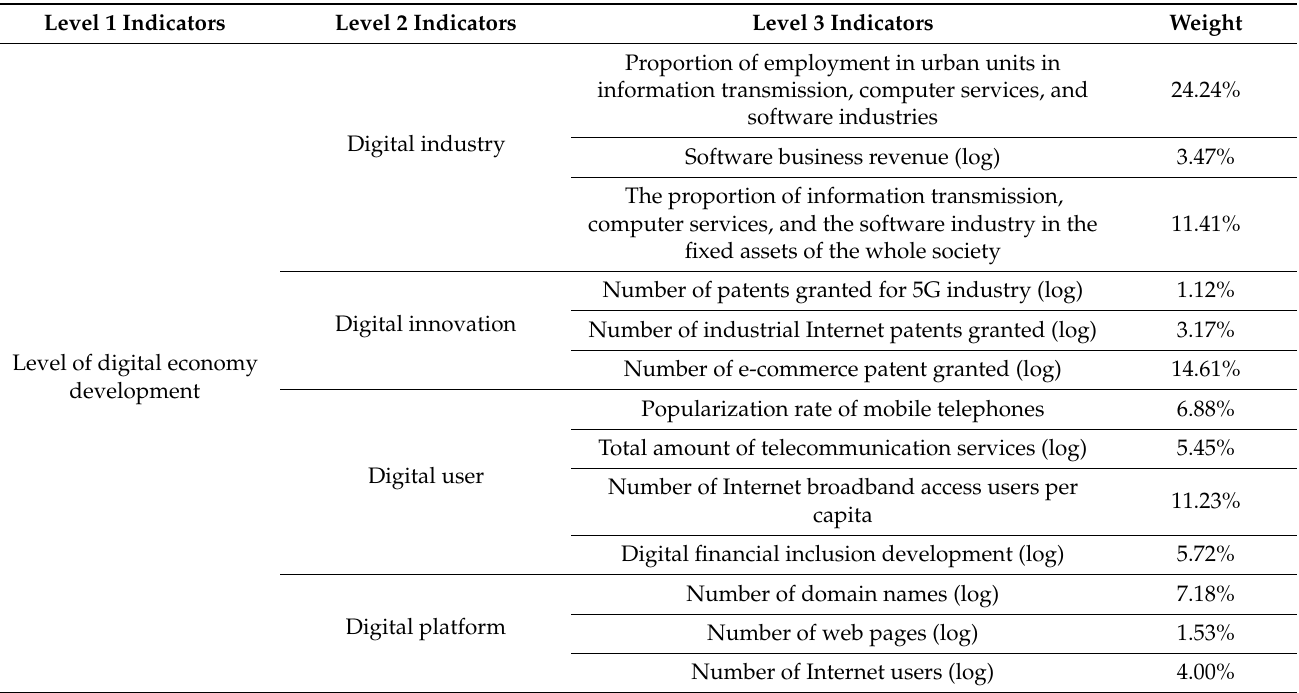
Table 1. Digital economy indicator